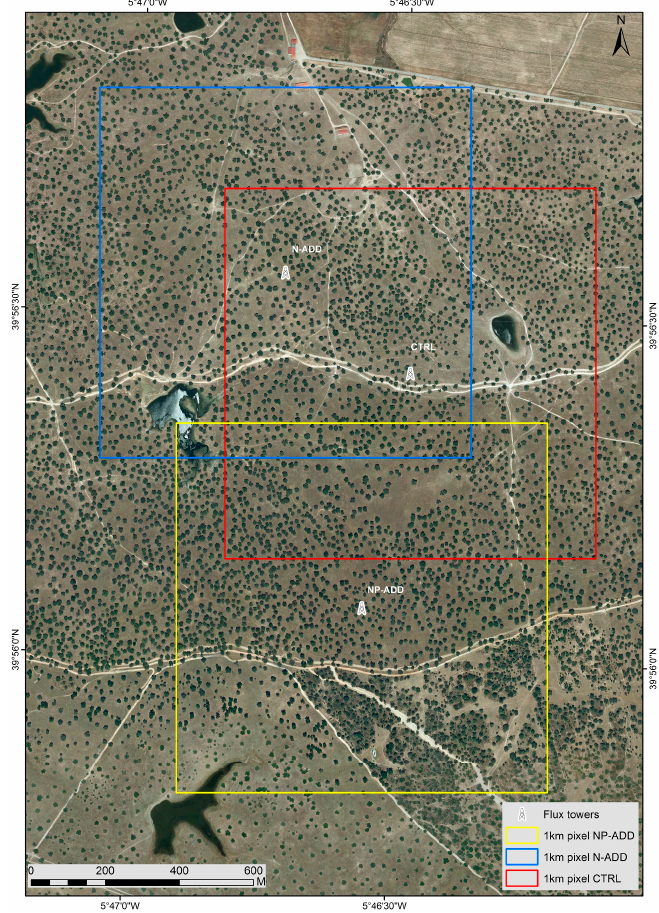
Figure 1. Location of the flux towers in Majadas del Tiétar. Each square corresponds to a synthetic 1 km pixel centered on each one of the towers.